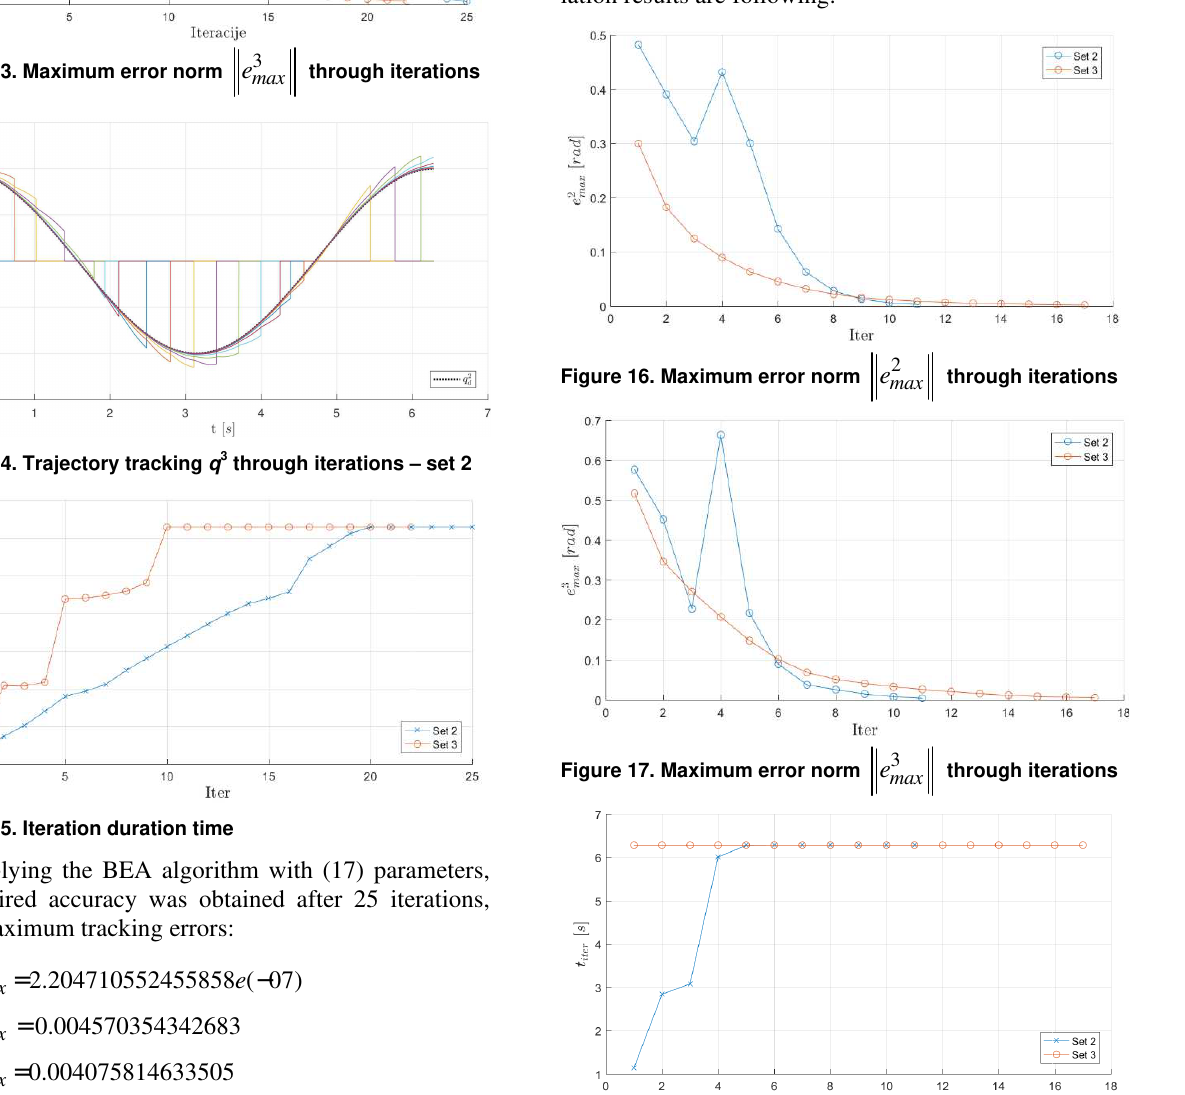
Figure 18. Iteration duration